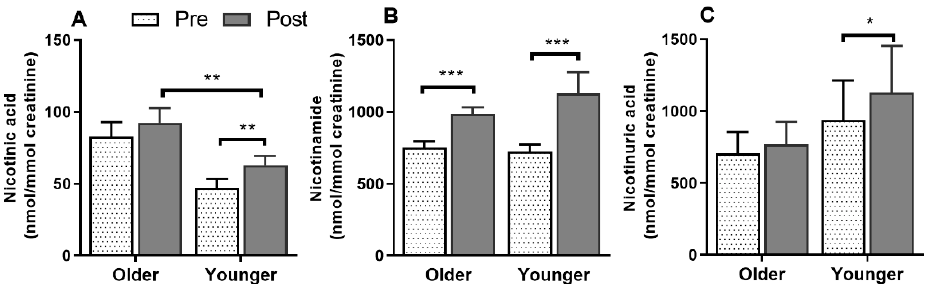
Figure 8. Urinary concentrations of the vitamers of vitamin B 3 , ( A ), nicotinic acid, ( B ), nicotinamide, and ( C ) nicotinuric acid at baseline (pre) and after (post) supplement ingestion in older and younger adults. Bar plots and error bars represent means and ± SEM respectively, n = 20 in each age groups and concentrations are normalized for urinary creatinine (nmol/mmol creatinine). Data for pre and post supplement ingestion was compared using generalized linear repeated measures analysis of variance with time as within subject and age as between subject factor. Sidak post hoc test was applied for pairwise comparisons in case of an interaction. There were no interactions between any independent factors (age and time). There were main time effects (*, p < 0.05; **, p < 0.01; ***, p < 0.001) for all the vitamers and a main age effect for nicotinic acid (**, p = 0.007).